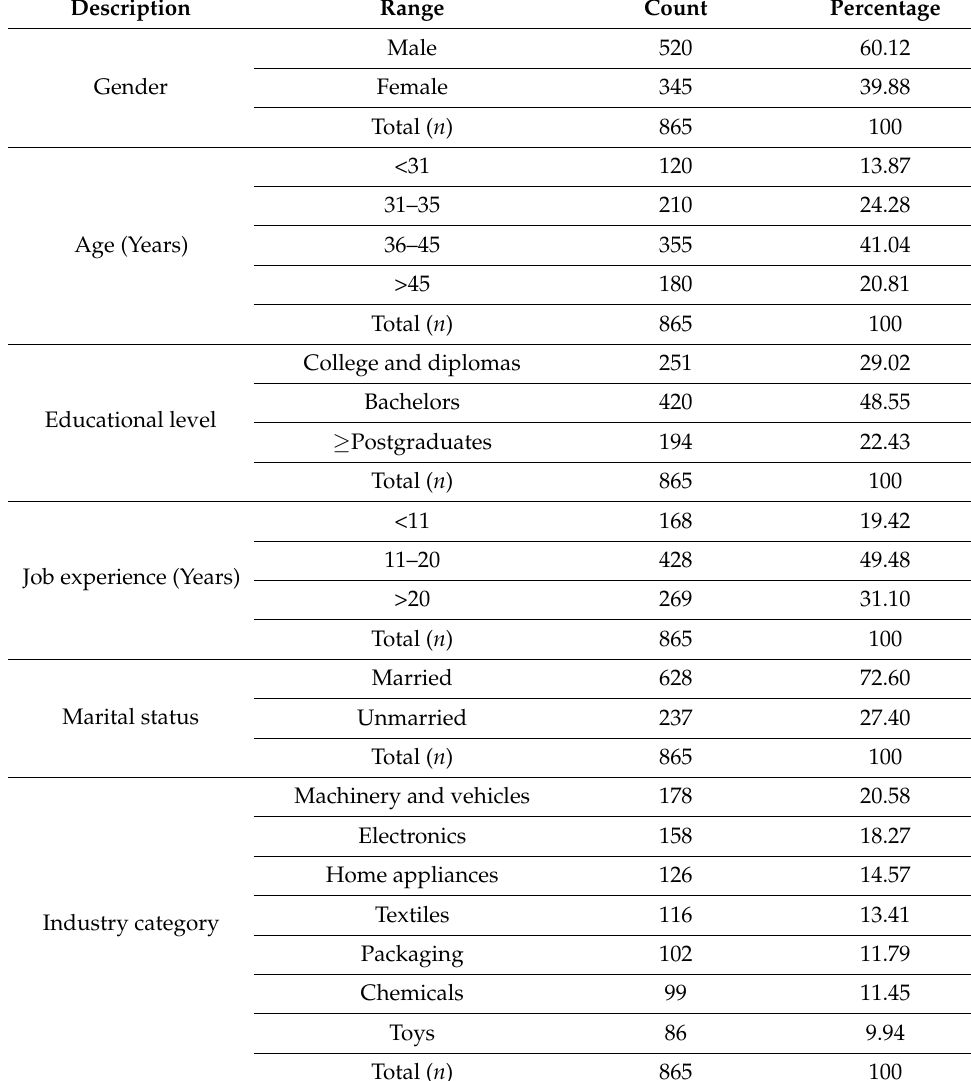
Table 1. Profile information of the survey